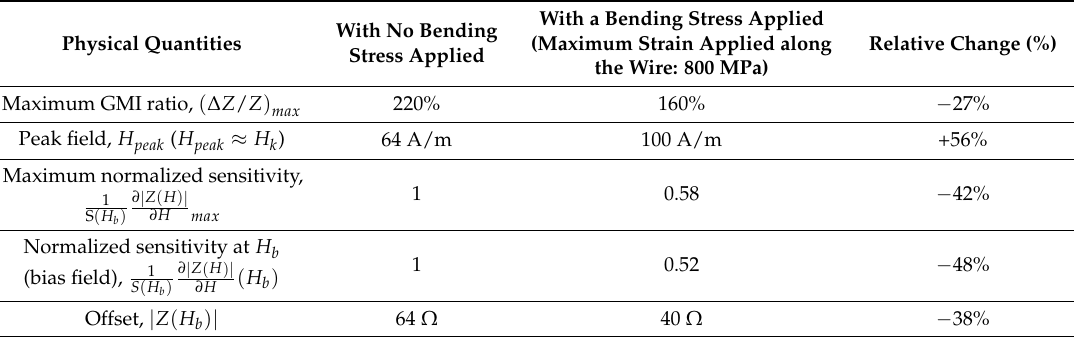
Table 1. Summary of the results obtained with an amorphous Co-rich wire, with a bending stress applied.